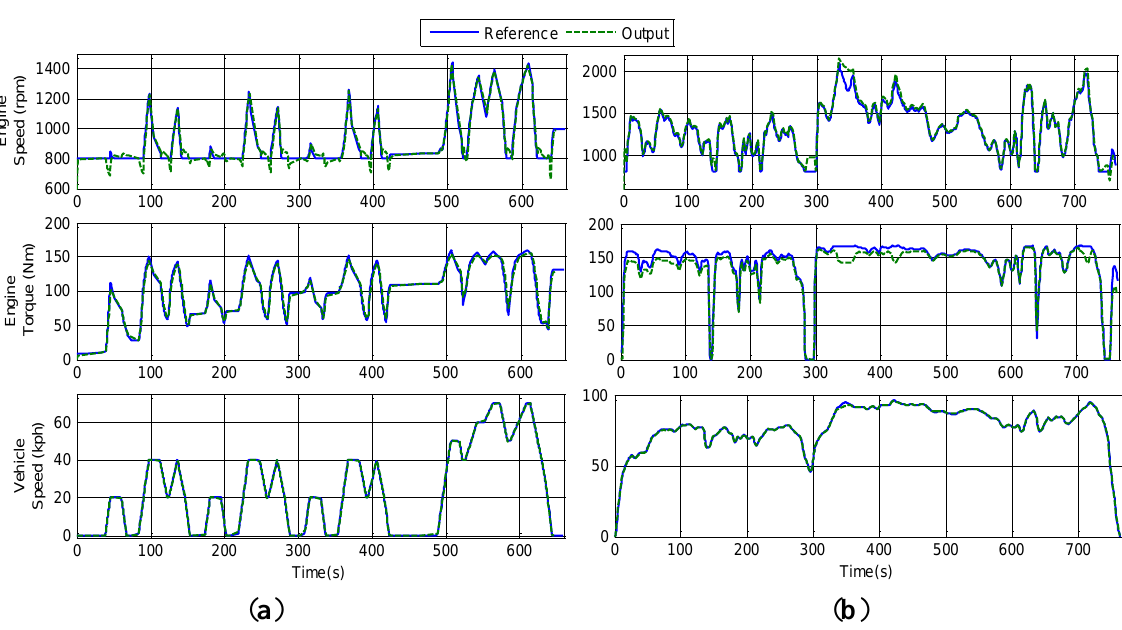
Figure 10. System behaviors: ( a ) Under Japan 1015; and ( b ) Under HWFET.